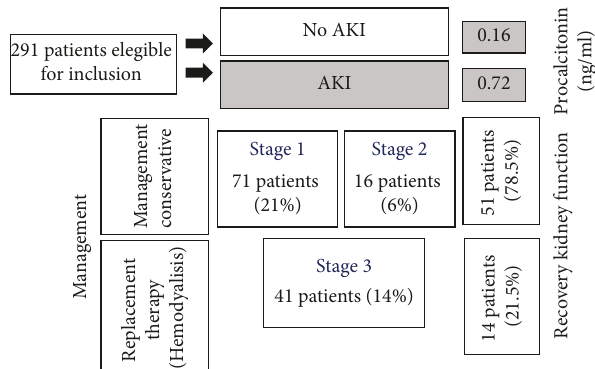
Figure 1: Clinical course, management, and recovery of the kidney function in patients who developed AKI with COVID-19. Table 2: Markers of inflammation on hospitalization and during follow-up in patients with COVID-19 and acute kidney injury (AKI). AKI total AKI 1 AKI 2 and 3 N � 118